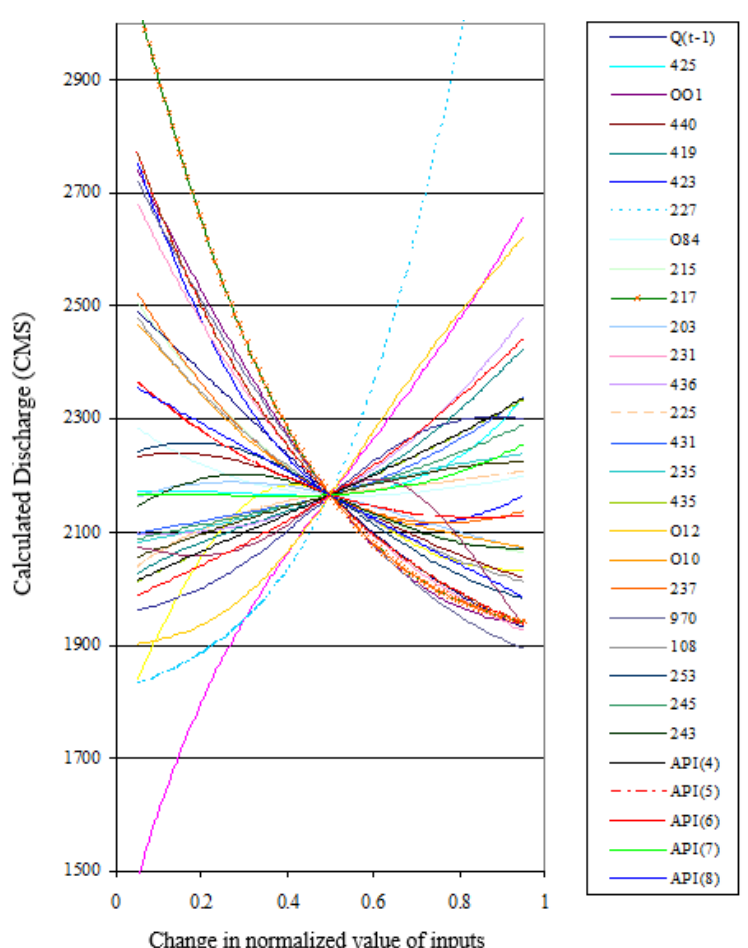
Fig. 10. Sensitivity analysis for ANN model with 26 input variables to forecast 𝑄(𝑡 +